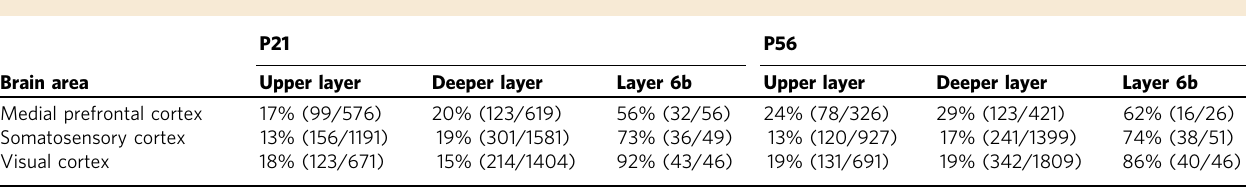
Fig. 5 OTR cell types in the cortex. a – n Gad67 antibody immunohistochemistry staining (red) from motor-somatosensory cortical area at around bregma A/P = − 0.7 mm from P21 a – g and P56 h – n Otr-Venus mice (green). Scale bar in a , h = 100 µ m. Examples of high magni fi cation images in the upper layer b – d , i – k and the layer 6b e – g , l – n from boxed areas in a , h . Scale bar in d , g , k , n = 100 µ m. White arrows for examples of Venus ( + ) cells co-expressing Gad67, and yellow arrows for Venus ( + ) cells without Gad67 colocalization. L1 in b , i for the layer 1, cc in e , l for the corpus callosum. Table 1 Gad67 colocalization with cortical OTR-Venus